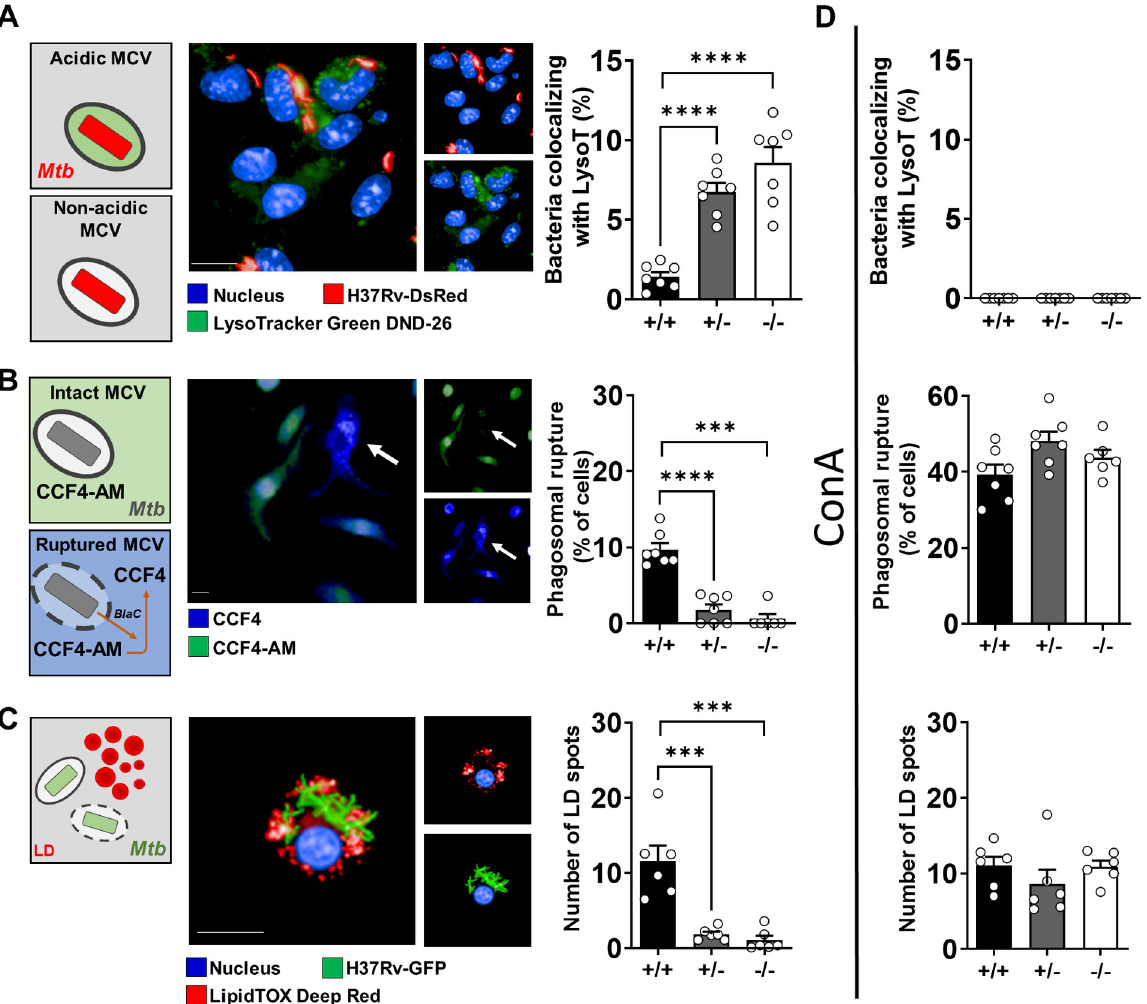
Fig 3. Tirap implication in phagosomal maturation and lipid droplet formation. Typical images and related quantifications (representative of two independent experiments) of phagosome acidification ( A ), phagosome rupture ( B ) and lipid droplet formation ( C ) of Mtb H37Rv infected BMDMs treated ( D ) or not with ConA. ( A ) DAPI-labelled cell nuclei are shown in blue, Mtb H37Rv-DsRed in red and acidic-pH-sensitive LysoTracker staining in green. The LysoTracker signal was set to the minimum in non-infected controls. Bar: 10 μ m. Histograms showing mean ± SEM obtained from 7 wells of the percentage of bacteria displaying a Lysotracker signal within the cells. ( B ) Representative images showing cells displaying CCF4-AM staining (green) or CCF4 staining (blue) corresponding to phagosomal rupture. Histograms showing mean ± SEM obtained from 7 wells of the percentage of BMDMs detected with phagosomal rupture 24 hpi. Bar: 5 μ m. ( C ) Representative images showing LD in Mtb infected cells. DAPI-labelled cell nuclei are in blue, Mtb H37Rv-GFP is in green, and LD staining (LipidTox) is in red. Bar: 5 μ m. Histogram showing the average number ± SEM of LD per cell at 96 hpi obtained from at least 6 wells. LD: lipid droplets, � P value < 0.05, �� P value < 0.01, ��� P value < 0.001, ���� P value < 0.0001, as determined by one-way ANOVA test.